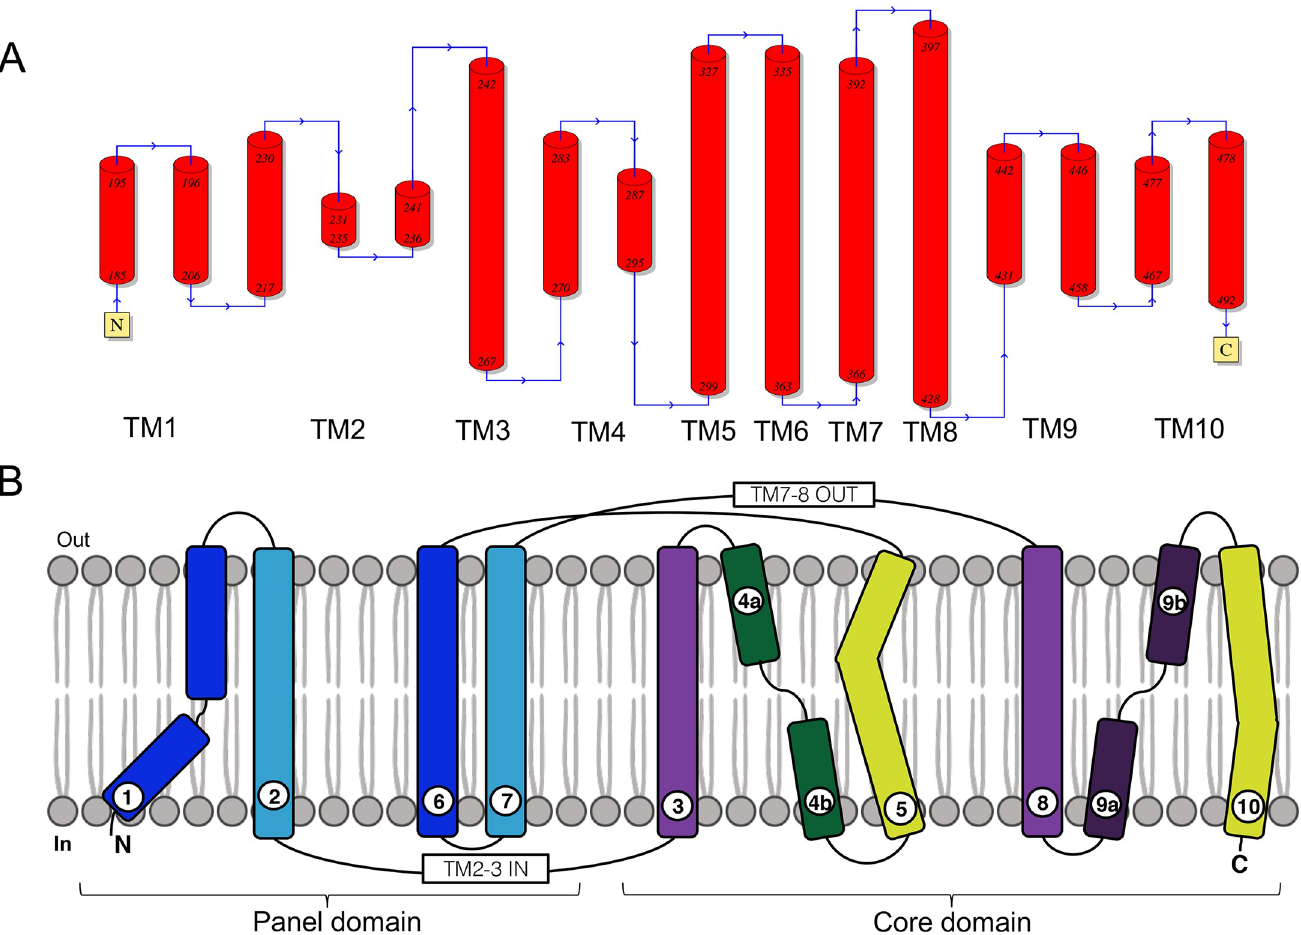
Fig 2. CsSBAT membrane topology and inverted structural repeats. (A) CsSBAT membrane topology was predicted based on the templates NmASBT (PDB ID: 3zuy_A) and ProFunc. Red barrels indicate α -helices. (B) N-terminal transmembrane domains (TMs) 1–2 and 3–5 were inversely repeated with C-terminal TMs 6–7 and